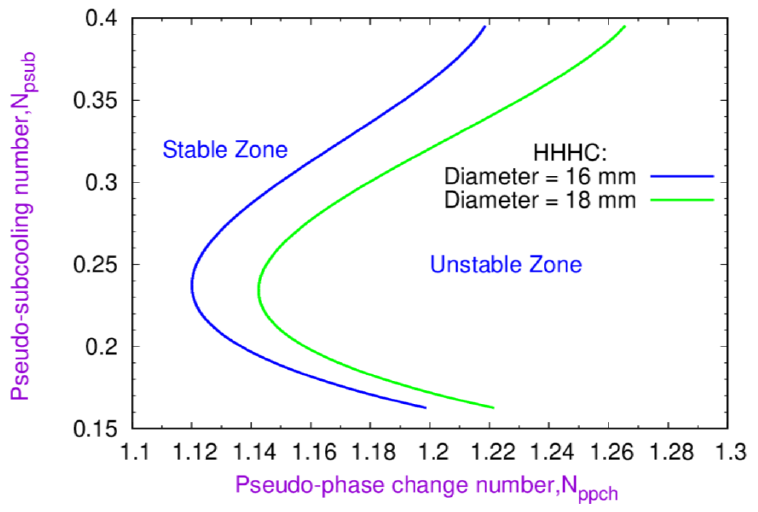
Figure 7. Comparison of stability MSBs at two different diameters, i.e., 16 and 18 mm.